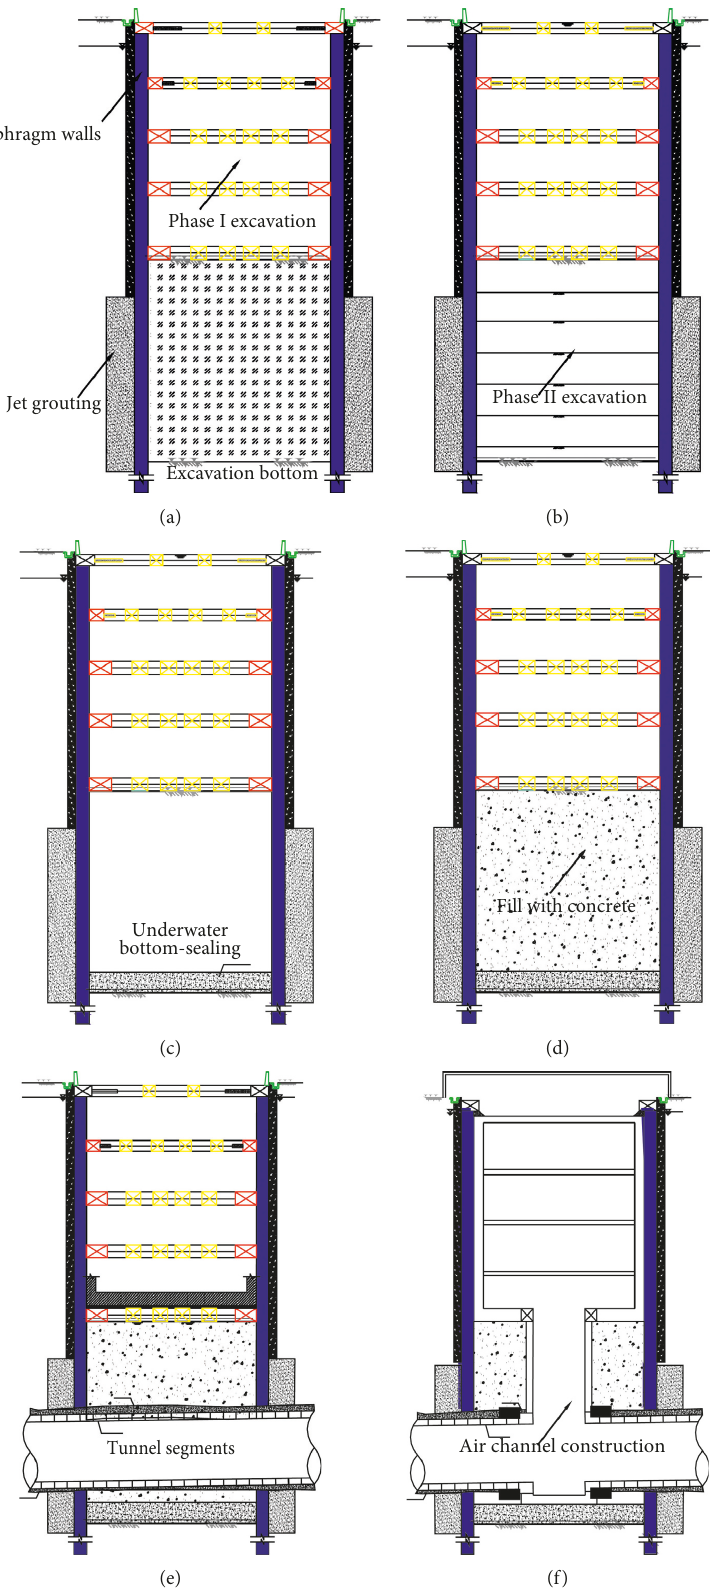
Figure 4: Construction procedure for the air shaft. (a) Dewatering and braced excavations. (b) Underwater excavation without drainage. (c) Underwater bottom-sealing construction. (d) Filling with low-grade concrete. (e) Shields passing through the air shaft. (f) Tunnel segments removed and construction of air